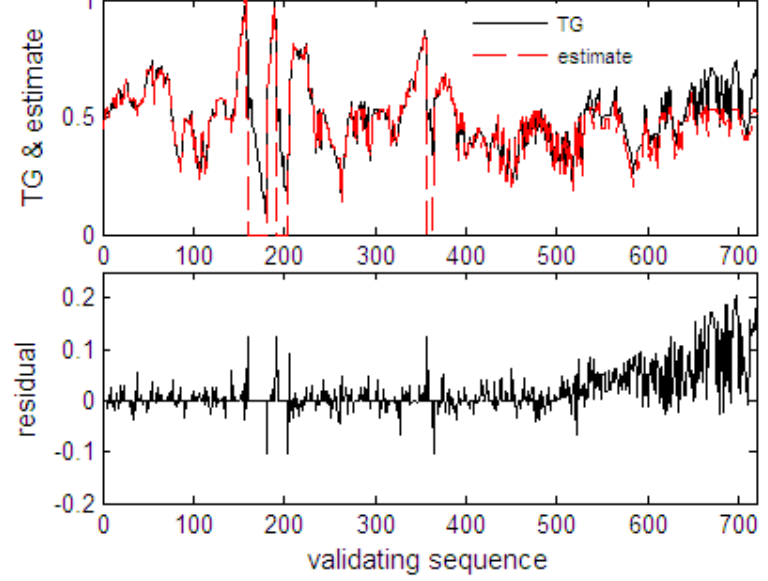
Figure 12. AAKR model estimate and residual in Case 2.